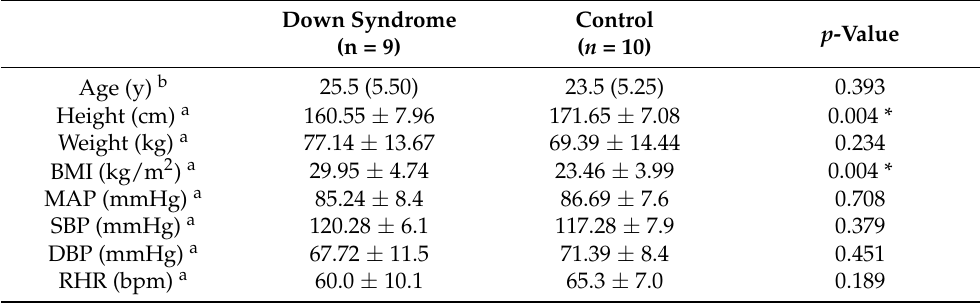
Table 1. Participant Characteristics.